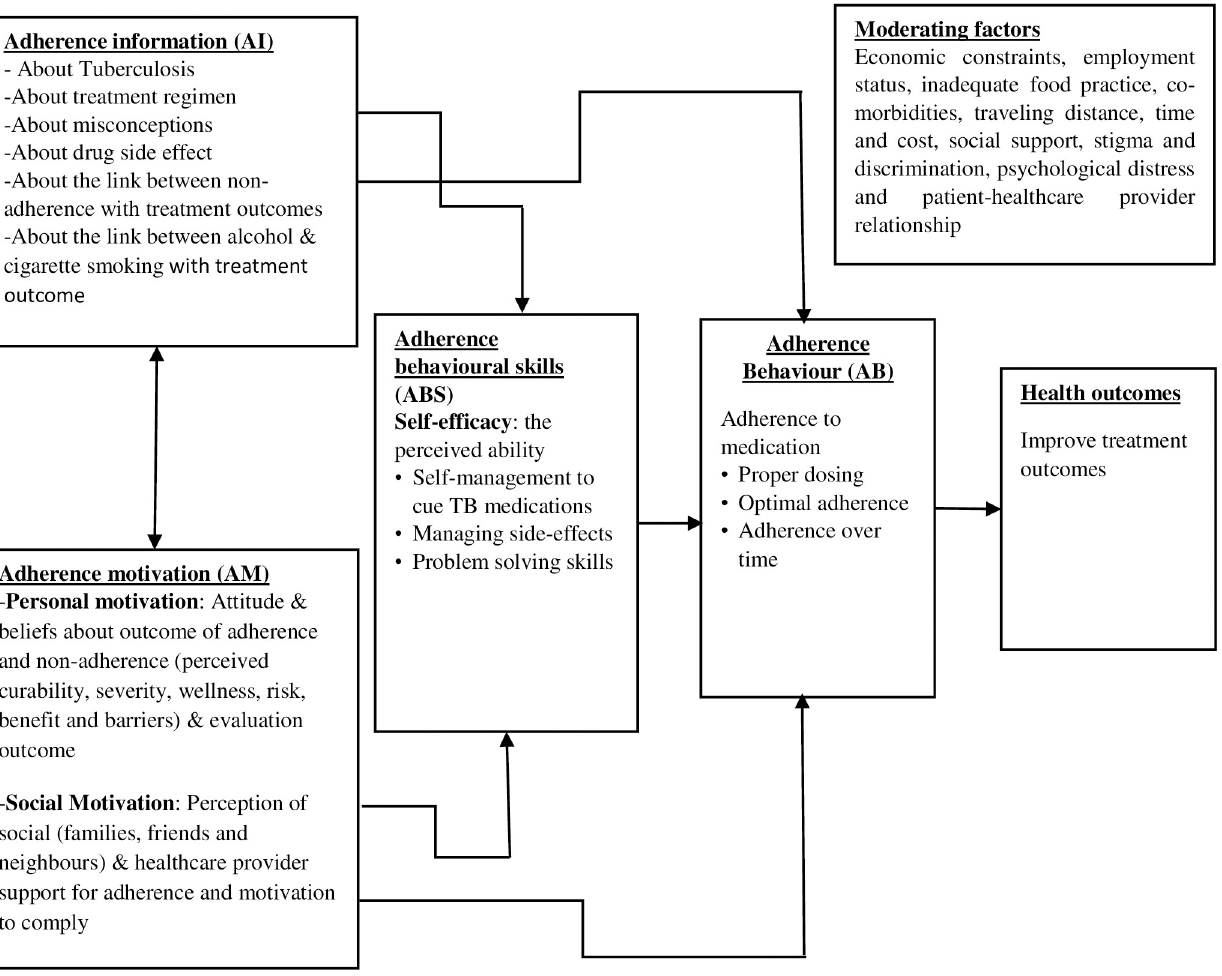
Fig 3. Information, motivation and behavioural skills model to Tuberculosis medication adherence adapted from Fisher et al. 2006 [42].